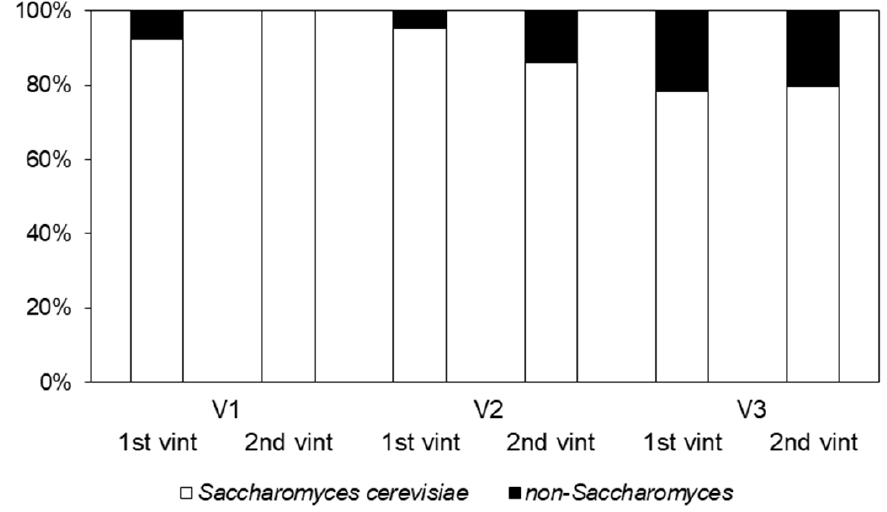
Figure 1. S. cerevisiae and non- Saccharomyces distribution across the vineyards (V1, V2, V3) and the first and second vintage (1st vint, 2nd vint). The isolates corresponding to S. cerevisiae species were classified comparing their mtDNA restriction patterns, establishing 54 different genetic groups designated as oper- ational taxonomic units (OTUs) (Figure 2). In concordance with these results, previous studies, which focused on identification of S. cerevisiae strains by mtDNA-RFLP technique in wineries throughout spontaneous fermentation, revealed a high diversity of S. cerevisiae populations [5,22]. The distribution of the isolates in each OTU was not homogeneous, with more than half of the isolates belonging to OTUs Sc01 and Sc02 (134 and 92 isolates, respectively). The remaining isolates were distributed as follows: 6 OTUs were formed by a number of isolates between 11 and 26, 10 of them included between 3 and 10, 9 OTUs contained 2 isolates and 27 OTUs were represented by one isolate (Figure 2). Relative abundance of a strain above 10% has been considered by other authors as a dominant strain [5]. Taking into consideration the distribution and relative abundance of the described OTUs, Sc01 and Sc02 were considered as dominants during spontaneous fermentation, as their relative abundance widely exceeded this percentage, independently of vineyard or